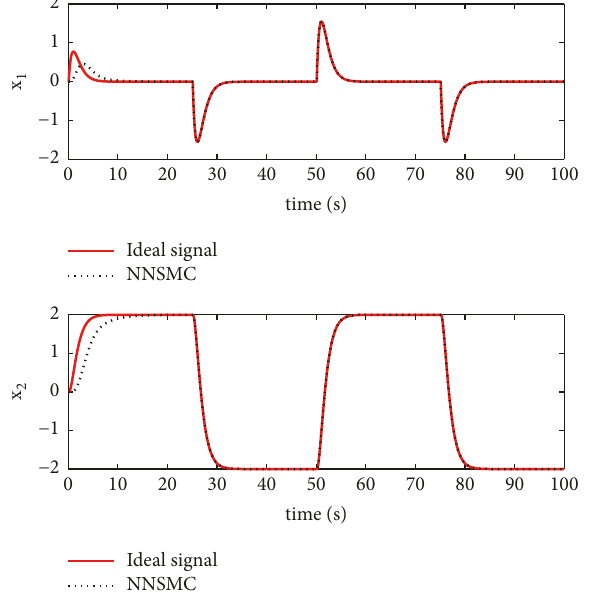
Figure 3: The control results of NNSMC versus PID control.